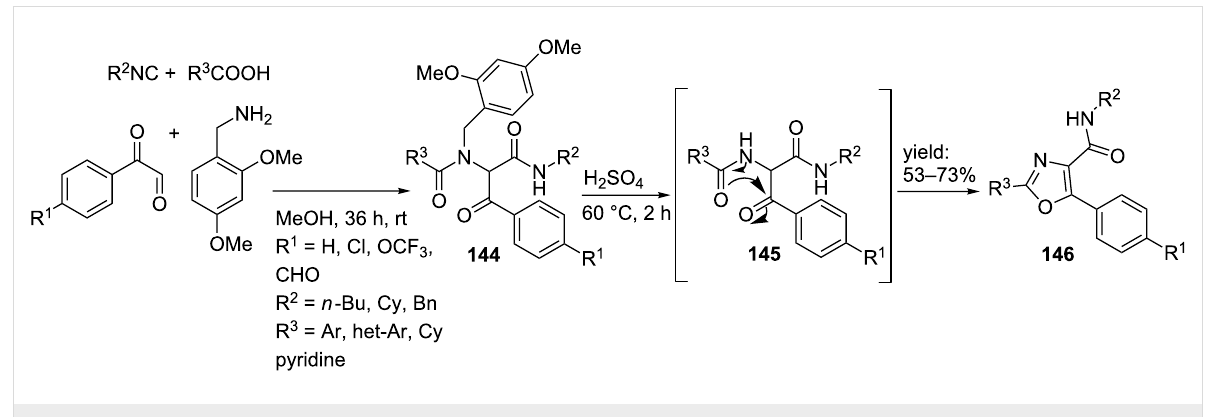
Scheme 44: Ugi-based synthesis of oxazole-containing